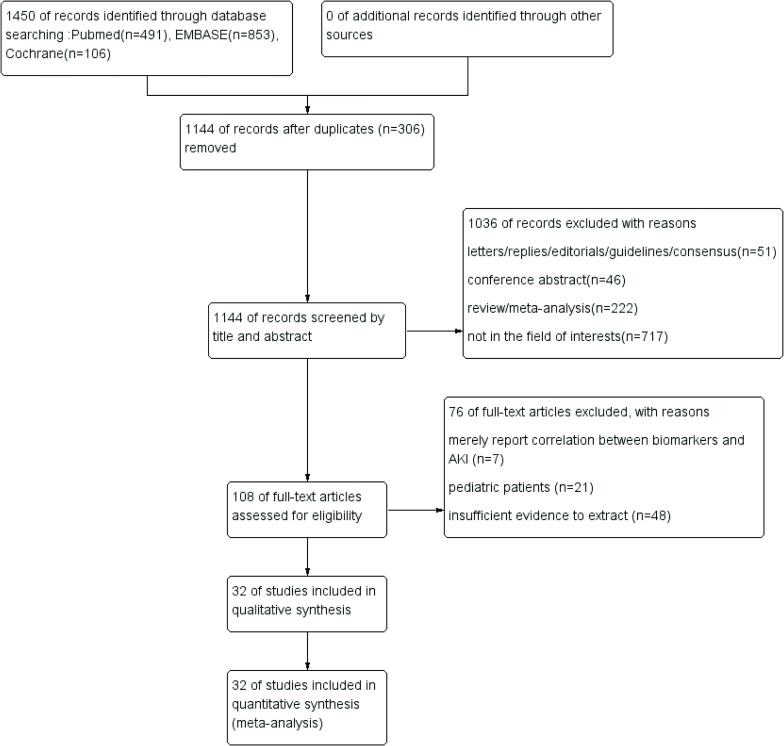
The process of study search and selection.